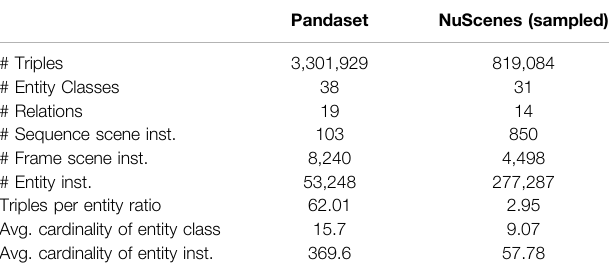
TABLE 3 | Basic KG statistics of Pandaset (DSKG-P) and NuScenes, sampled at 4s (DSKG-N).